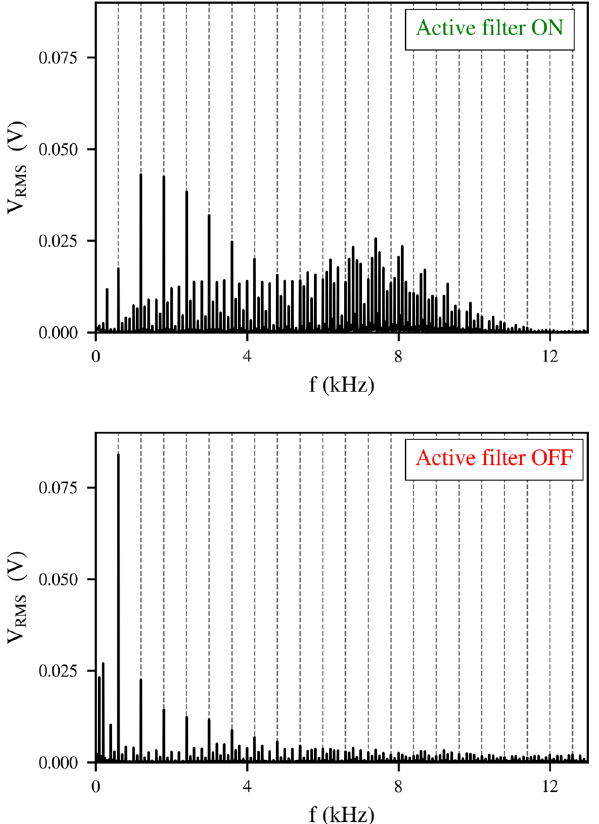
FIG. 16. Voltage spectrum of the power supply of the main dipoles in one of the LHC arcs (Sector 1-2) with the active filter enabled (top) and disabled (bottom). The vertical gray lines represent the multiples of 600 Hz.